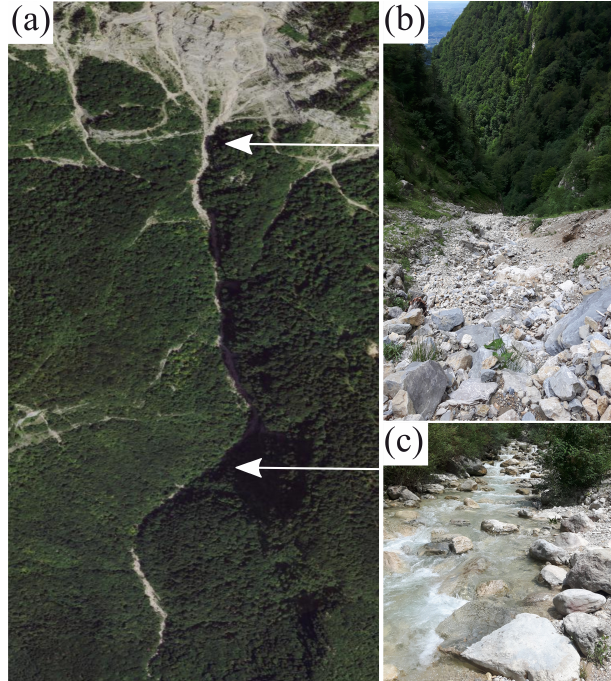
Figure 1. (a) The Roize River, a typical mountain stream config- uration with (b) a production zone with sediment deposits that are several metres thick and show evidence of large incisions and (c) a transfer zone consisting of a narrow steep step-pool morphology. Photo credit: (a) IGN France (https://www.geoportail.gouv.fr, last